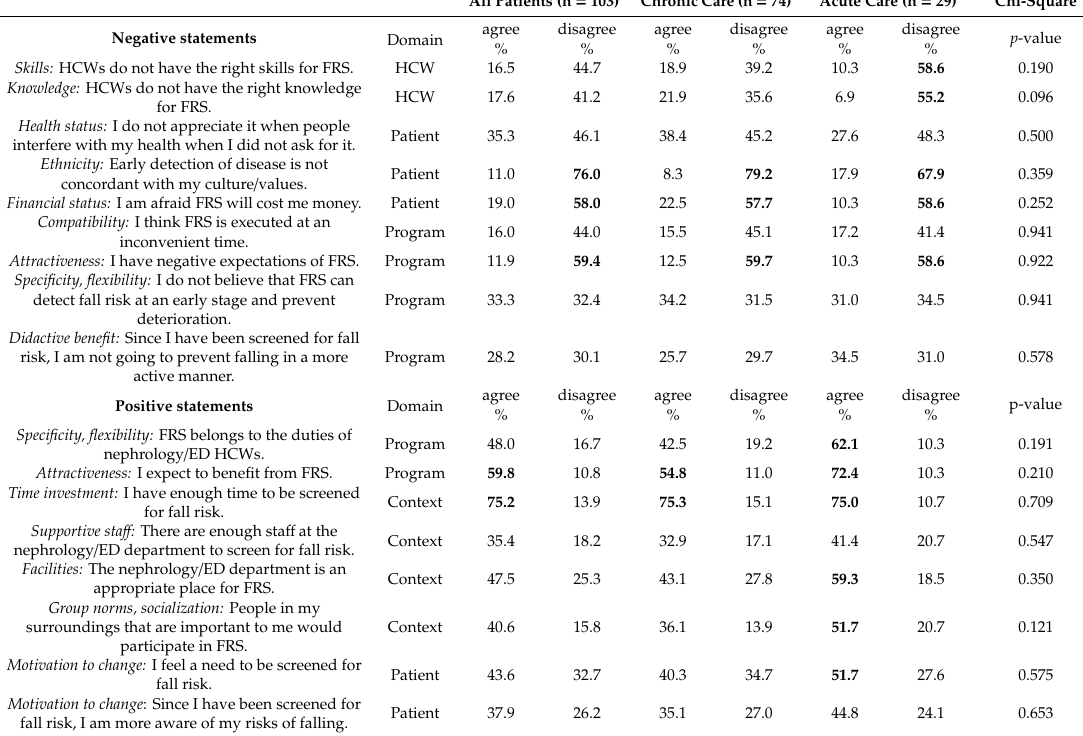
Table 2. Barriers and facilitators of chronic-care and acute-care patients considered in hospital fall risk screening. All Patients (n = 103) ChronicCare(n = 74) Acute Care (n = 29)